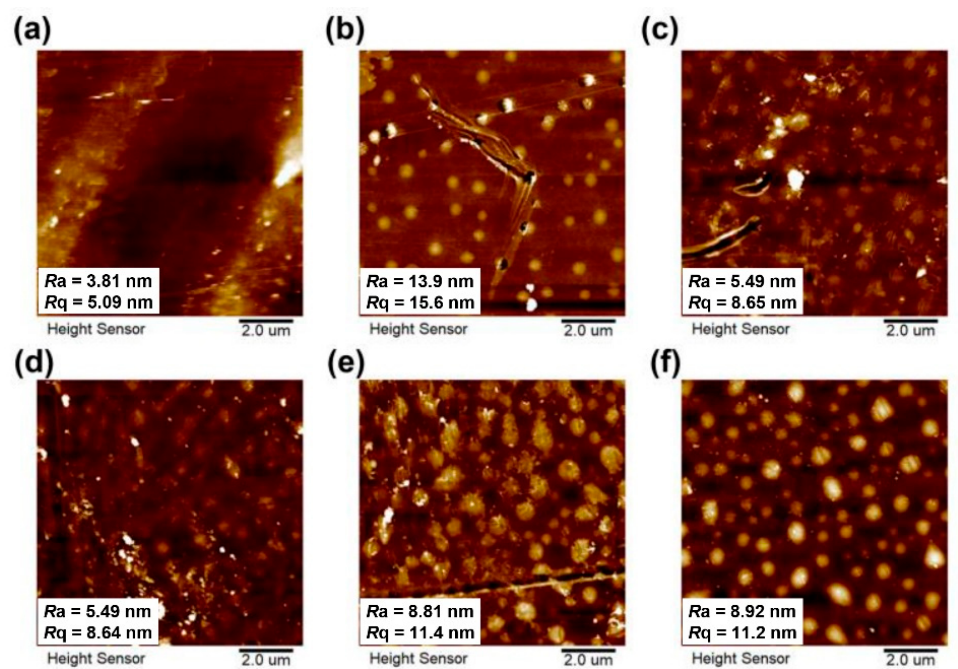
Figure 7. AFM images of 6FPI-POSS composite films with the surface roughness values. ( a ) 6FPI-0; ( b ) 6FPI-5; ( c ) 6FPI-10; ( d ) 6FPI-15; ( e ) 6FPI-20; ( f ) 6FPI-25.